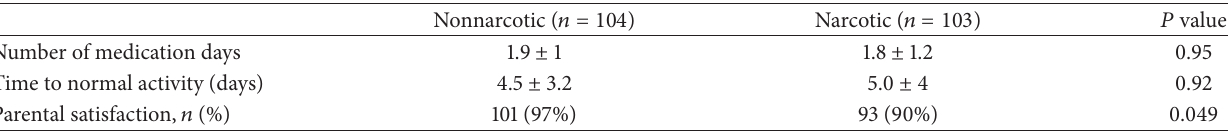
Table 2: Outcomes and parental